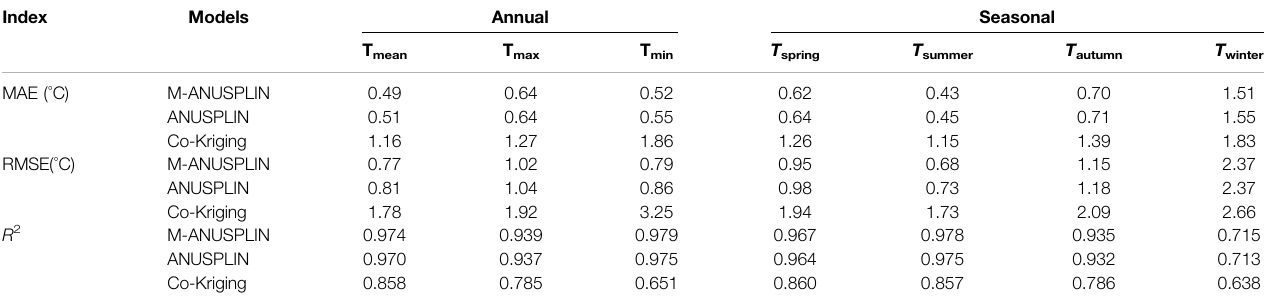
TABLE 2 | 10-fold cross-validation results of the co-kriging, ANUSPLIN, and M-ANUSPLIN models.